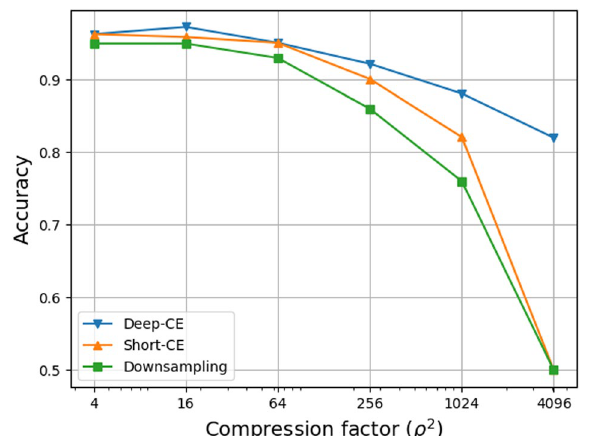
Fig. 2 Accuracy on the test set with deep/short-CE and down-sampling with anti-aliasing filter. This figure makes a comparison on the accuracy degree obtained in the test set of the GTSRB dataset considering images compressed through deep-CE, short-CE and a classical down-sampling with anti-aliasing filter